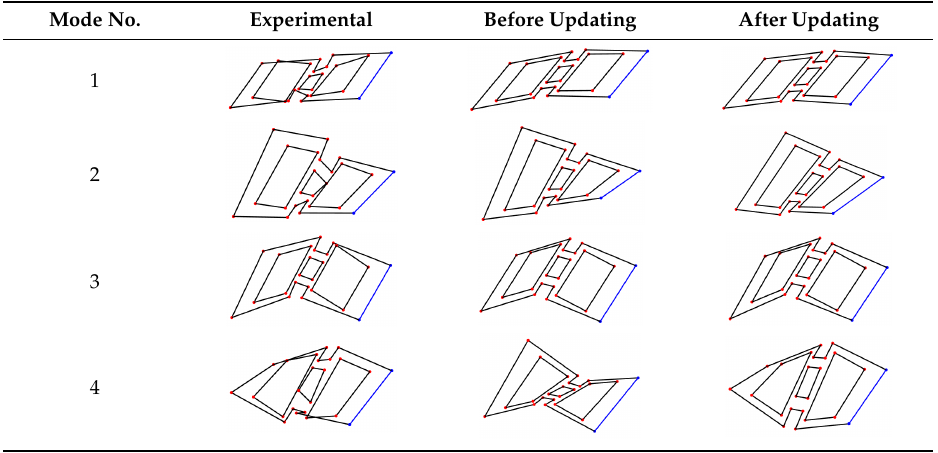
Table 9. Comparison of Modal Shapes Before and After Model Updating.